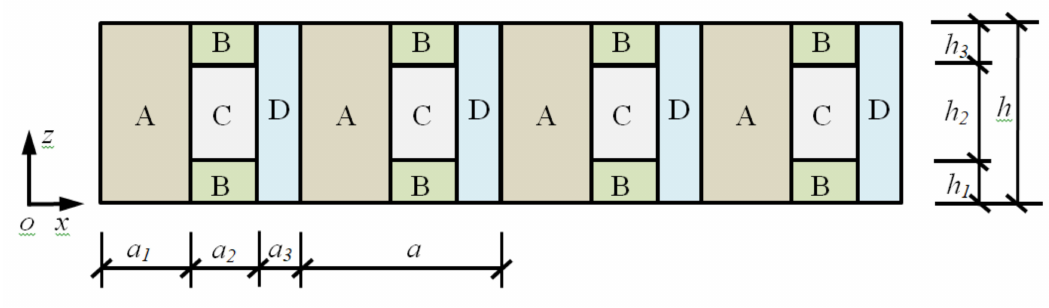
Figure 1. A phononic crystal plate.